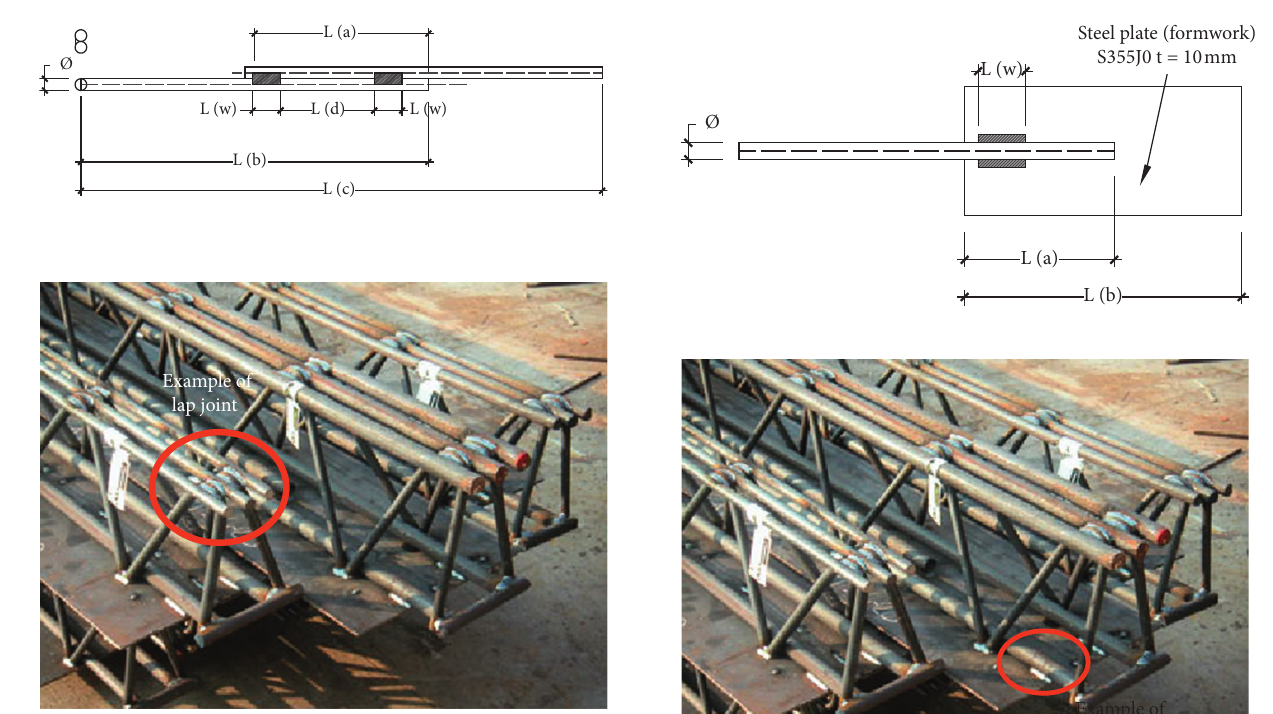
Figure 2: Lap Joint specimens.